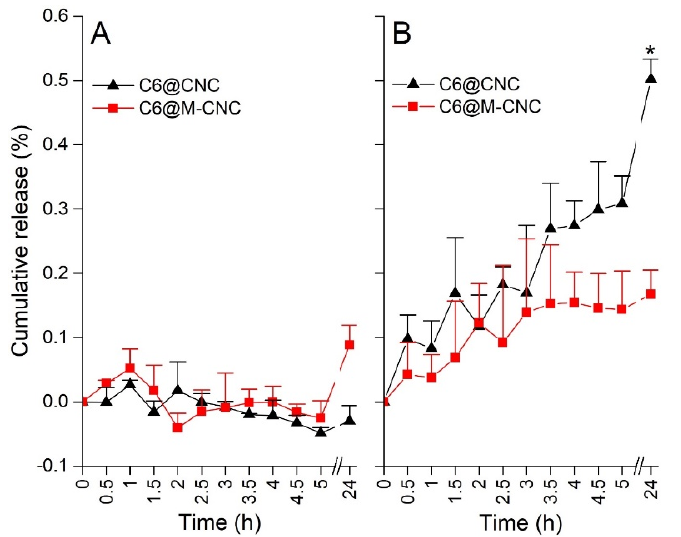
Figure 5. The release kinetics of encapsulated C6 from C6@CNCs and C6@M-CNCs in ( A ) HBSS-HEPES (pH 7.5) and ( B ) HBSS-MES (pH 6.8) buffers. Results are shown as mean ± SEM ( n = 3). Both the C6@CNCs and C6@M-CNCs showed release in HBSS-MES, with C6@CNCs demon- strating significantly ( p < 0.05) more release than C6@M-CNCs at 24 h (data point marked with an asterisk).